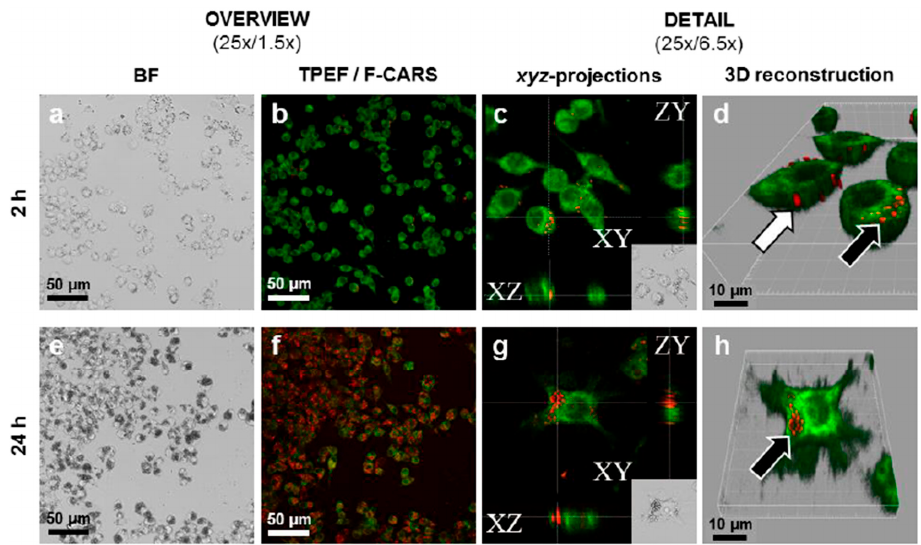
Figure 3. Interactions between paliperidone palmitate (PP) nanocrystals and RAW 264.7 macrophages imaged by CARS after 2 ( a – d ) and 24 h ( e – h ). Imaged is performed using CARS signal at 2860 cm − 1 and fluorescently dyed cell membranes are imaged using TPEF. ( a , e ) low and high magnification brightfield imaging; ( b , f ) forward-CARS (red)/TPEF (green) merged micrographs of stained/fixed cells; In ( c , g ) intracellular PP nanocrystals are seen in orthogonal projections of z-stacked F-CARS/TPEF overlays; ( d , h ) show 3D-reconstructions of the z-stacked F-CARS/TPEF overlays. White arrows indicate PP-NC adsorbed onto cell surface and black arrows phagocytosed PP-NCs. (From [21], reprinted from Elsevier with permission).